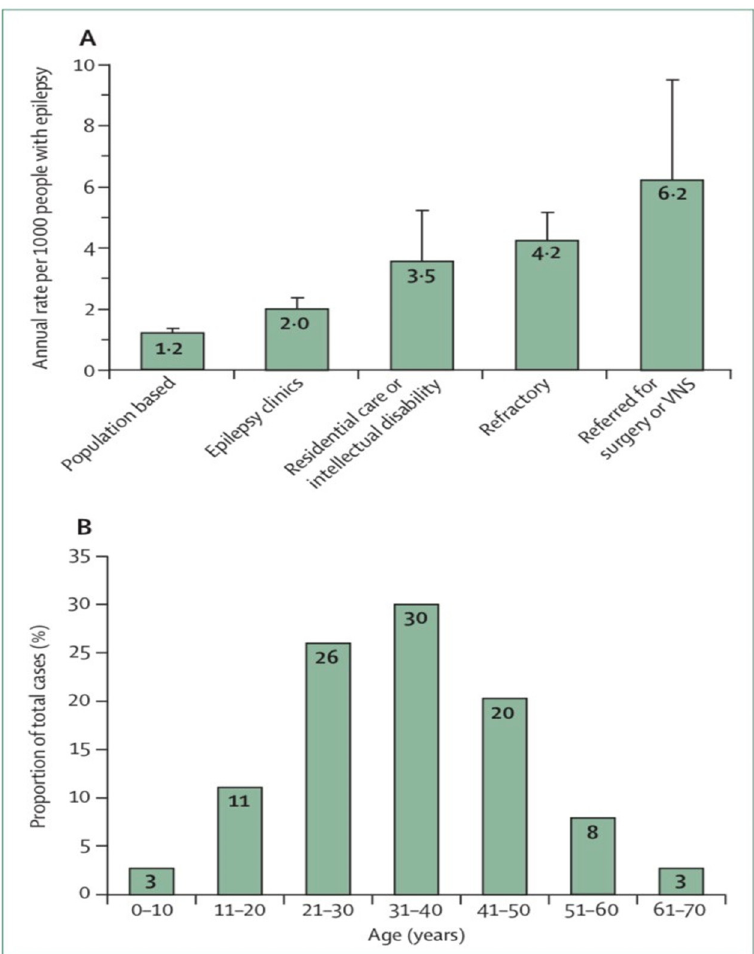
Figure 1. Sudden unexpected death in epilepsy epidemiology [7,14] ( A ) Estimated annual sudden unexpected death in epilepsy incidence in different epilepsy patient populations. ( B ) Distribution of sudden unexpected death in epilepsy cases by age. Error bars reflect 95% Cis. VNS = vagus nerve stimulation.